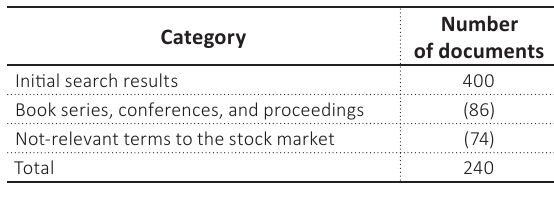
Table 1. Refinement of search results